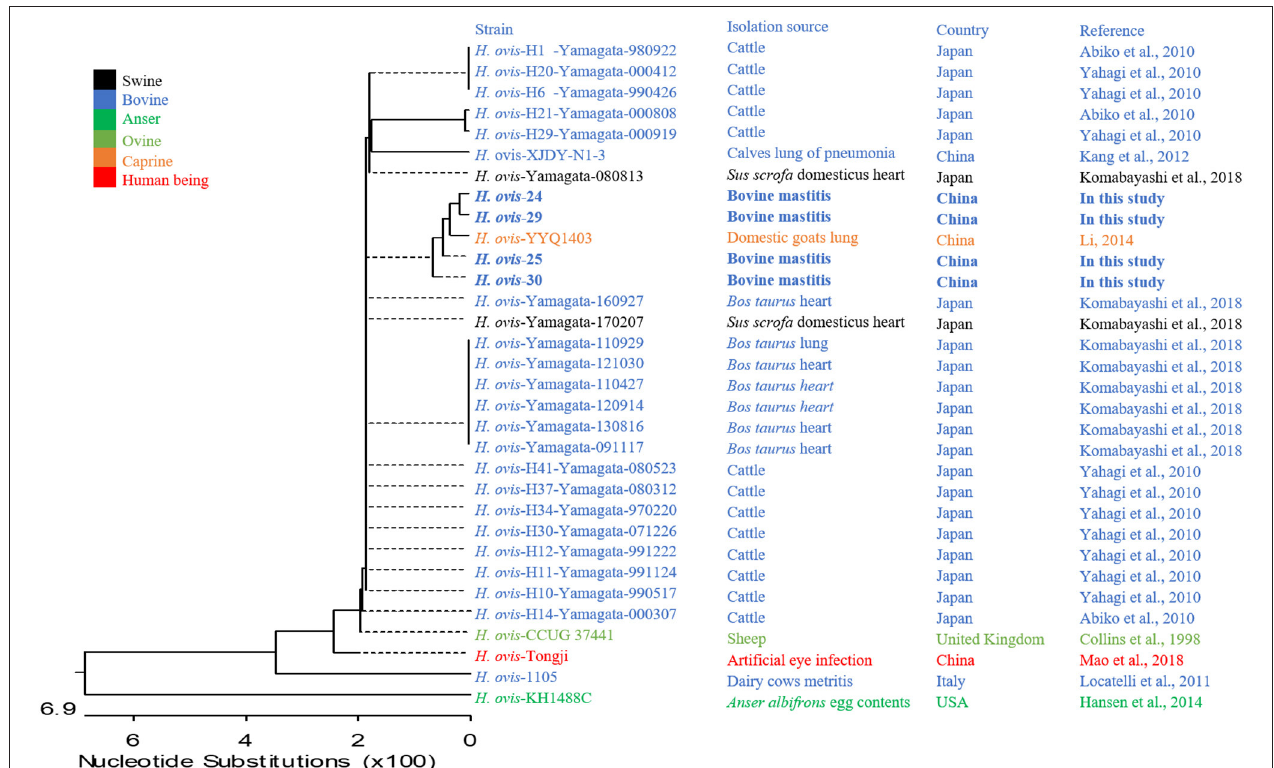
FIGURE 2 | Phylogenetic analysis of four strains of Helcococcus ovis. Bold fonts indicate Helcococcus ovis isolates in this study.